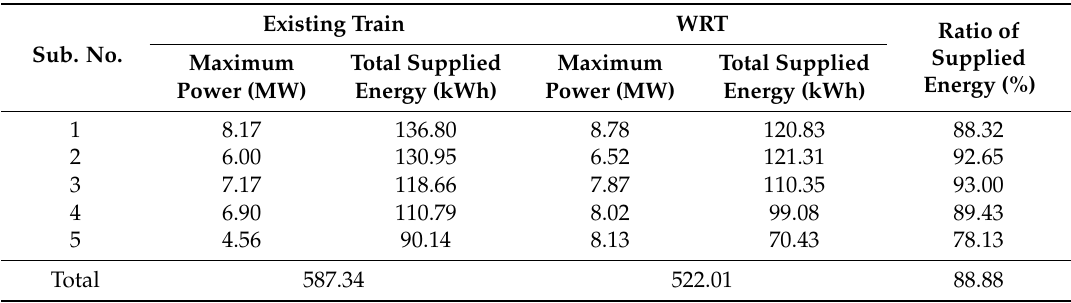
Table 3. Power simulation results for railway substation at peak headway condition.